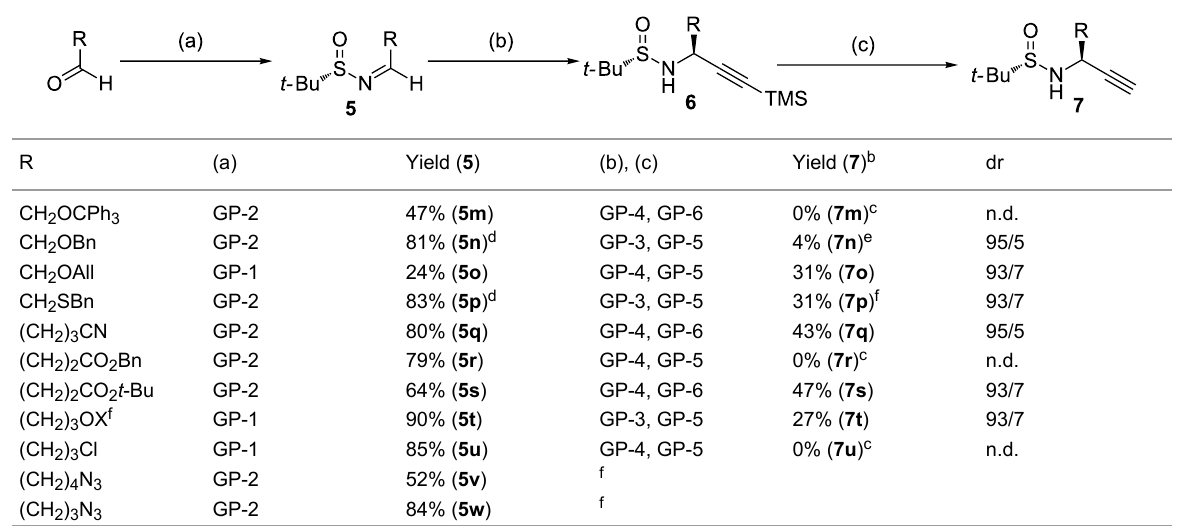
Table 3: Preparation of N- sulfinyl propargylamines 7 with polar and acidic functional groups in the side chains. a